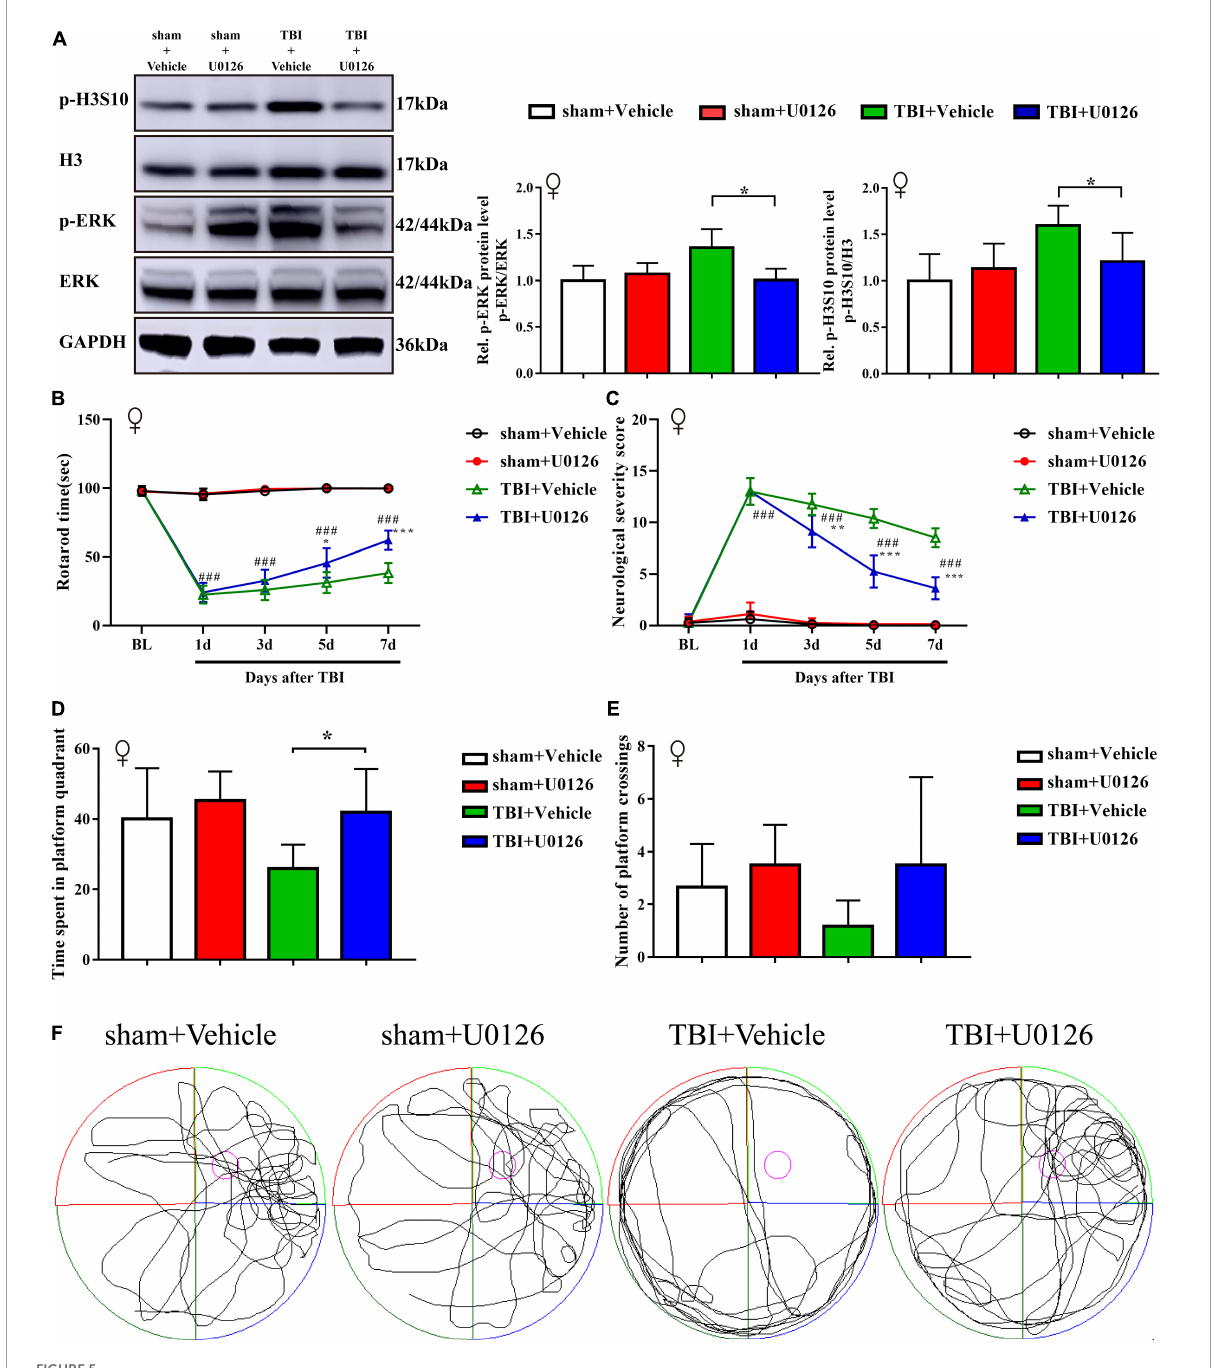
FIGURE5 Treatment with U0126 prevented the upregulation of p-ERK and p-H3S10 in female TBI rats, improved rotarod test and Morris water maze test performance, and attenuated neurological severity score in TBI female rats. (A) Western blot analysis showed that U0126 treatment reversed the phosphorylation levels of ERK and H3S10 (* p < 0.05) in TBI female rats ( n = 6 rats/group. Mann–Whitney test. TBI + U0126 vs. TBI + vehicle. The values are expressed as the means ± SD). Motor function was improved between the third and seventh days after injury by U0126 as shown in the rotarod test (B) and neurological severity score test (C) ( n = 8 rats/group. Two-way ANOVA with repeated measures followed by Tukey’s multiple comparisons test. * p < 0.05, *** p < 0.001, TBI + U0126 vs. TBI + vehicle; ### p < 0.001, TBI + U0126 vs. sham + U0126. The values are expressed as the means ± SD). Cognitive function was also improved as shown in the Morris water maze test (D,E) ( n = 6 rats/group. One-way ANOVA followed by Dunnett’s multiple comparisons test. * p < 0.05, TBI + U0126 vs. TBI + vehicle. The values are expressed as the means ± SD). (F) The swim paths shown for sham + U0126, sham + vehicle, TBI + vehicle and TBI + U0126 groups were those of a single female animal in the probe test. The hidden platform was indicated by the purple